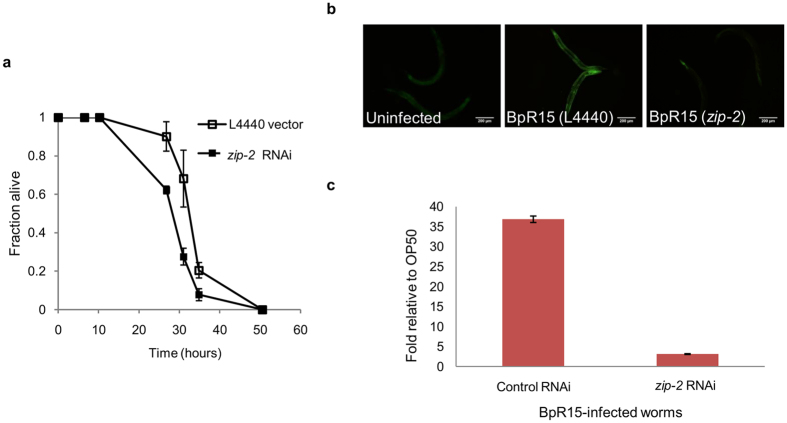
ZIP–2 is required to protect C. elegans from B. pseudomallei killing and to regulate the overexpression of ugt-29 in B. pseudomallei infected worms.(a) Graph denotes the killing kinetics of worms infected by BpR15 upon zip–2 RNAi knockdown. zip–2 knockdown worms exhibited increased susceptibility to B. pseudomallei infection (p < 0.0001 log-rank test). Error bars represent mean value ± SD. Shown is the representative of two independent experiments (n = 120). (b) Representative fluorescence micrographs (100× magnification) of BpR15–infected ugt–29::GFP reporter worms upon zip–2 RNAi knockdown at 6 hours post infection. The exposure time and gain factor are similar for all the micrographs taken. Scale bar, 200 μm. (c) qRT-PCR analysis of ugt-29 in BpR15-infected worms upon zip–2 RNAi knockdown at 6 hours post infection. Error bars represent mean values ± SD.